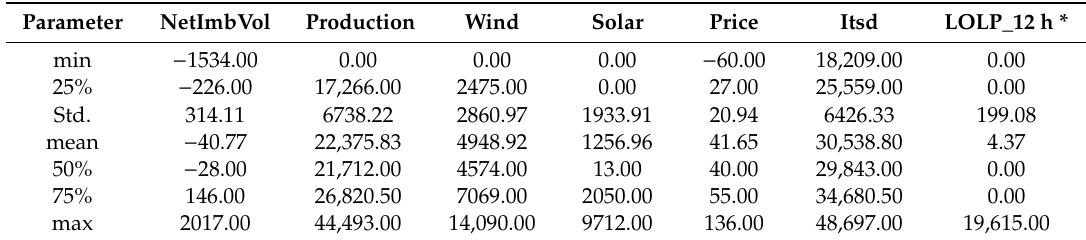
Table 1. Dataset summary of numeric and target variable